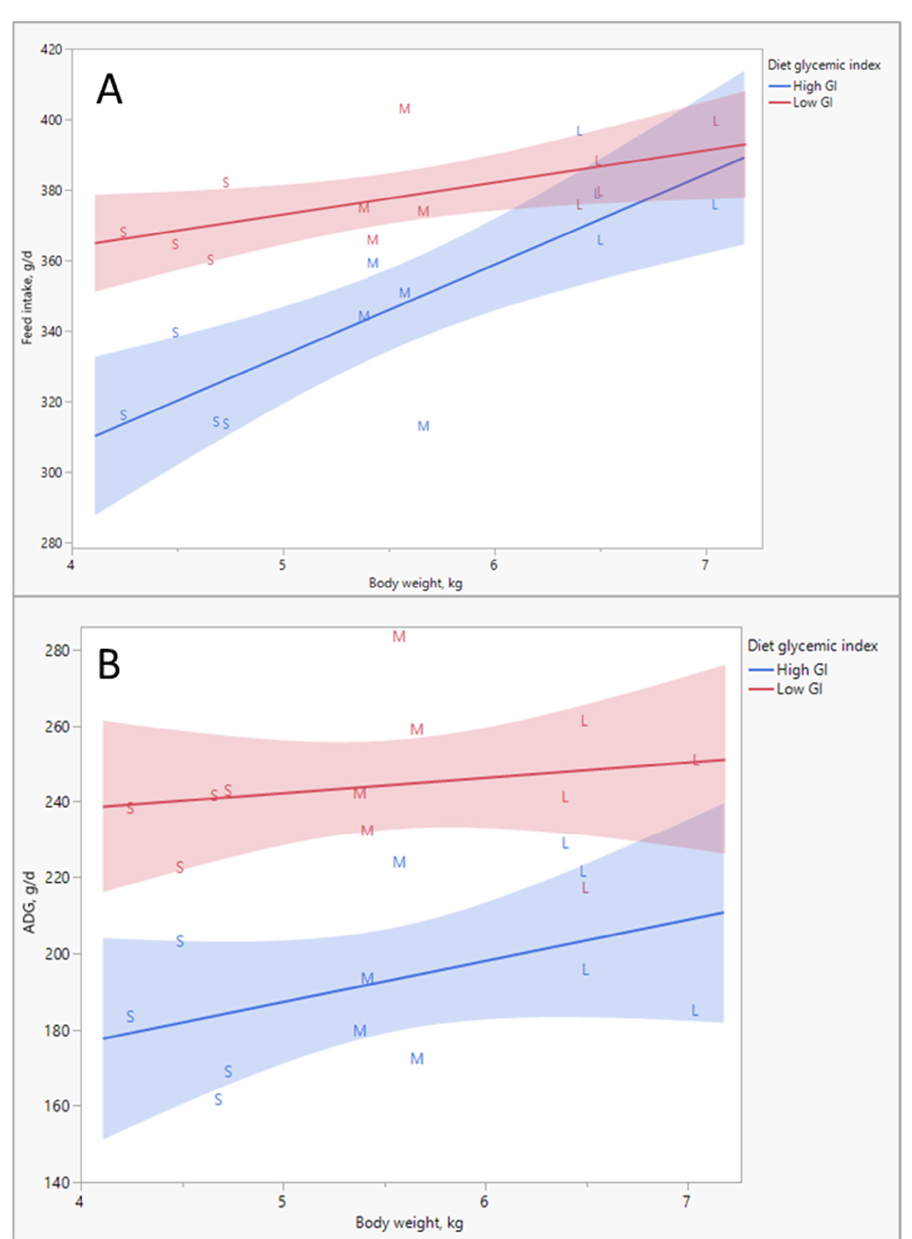
Figure 4. ( A ) Food intake versus body weight (BW) of Small (S), Medium (M) and Large (L) piglets at weaning when fed a diet with a low or high glycemic index (GI). ( B ) Gain (ADG, g/d) in piglets selected at weaning as small or as big as affected by the glycemic index of the diet. Small pigs represent a high proportion of animals predisposed to type II diabetes due to epigenetic programing